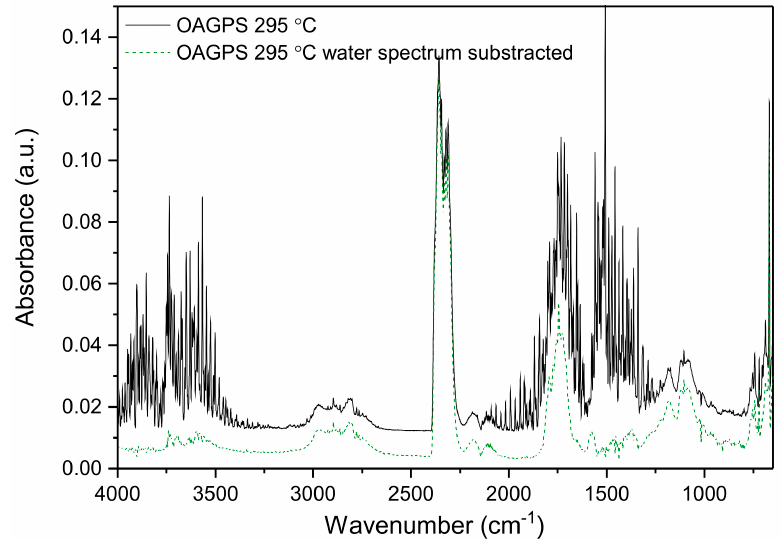
Figure 2. FTIR spectrum recorded at 295 °C for OAGPS sample. Table 1. Carbon yield after carbonization of aerogels at various temperatures based on thermogravimetric analysis coupled with evolved gas analysis with infrared spectroscopy detection (EGA(FTIR)-TGA) results. Carbon Yield (wt %) Sample Starch Type OAGPS potato starch maize starch